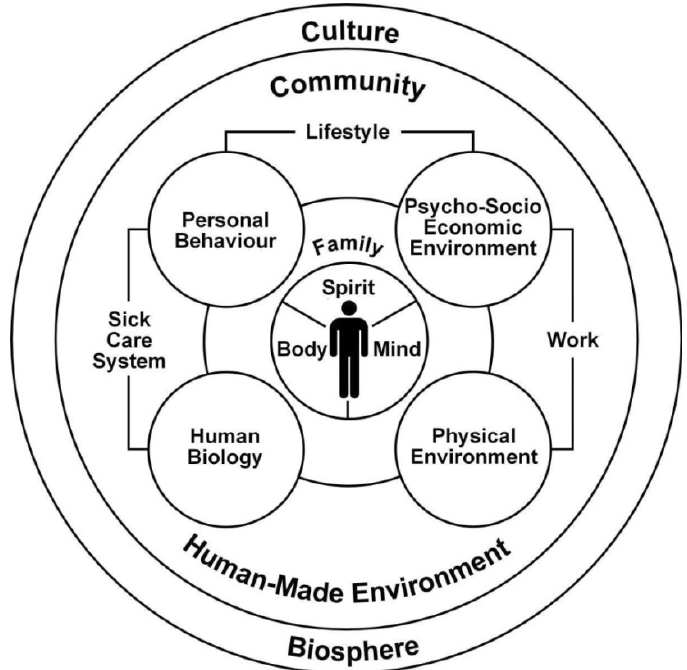
Figure 2. The Mandala of Health ( reprinted from [21] with permission from Oxford University Press ® ).